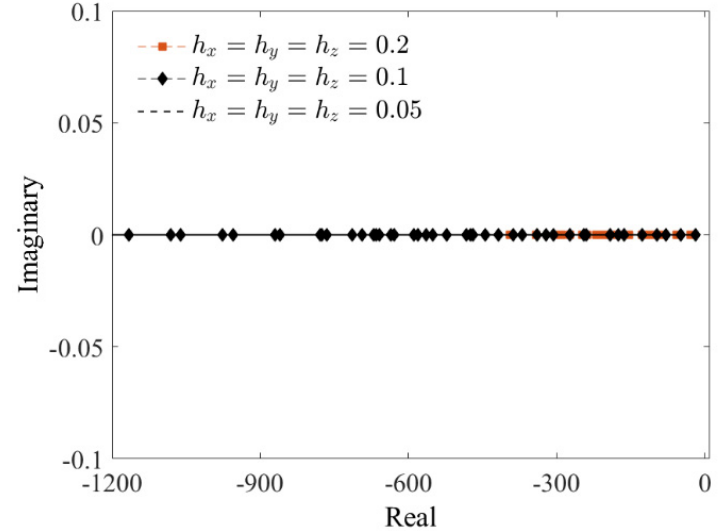
F . Figure 1. Eigenvalues of the matrix F 1 1